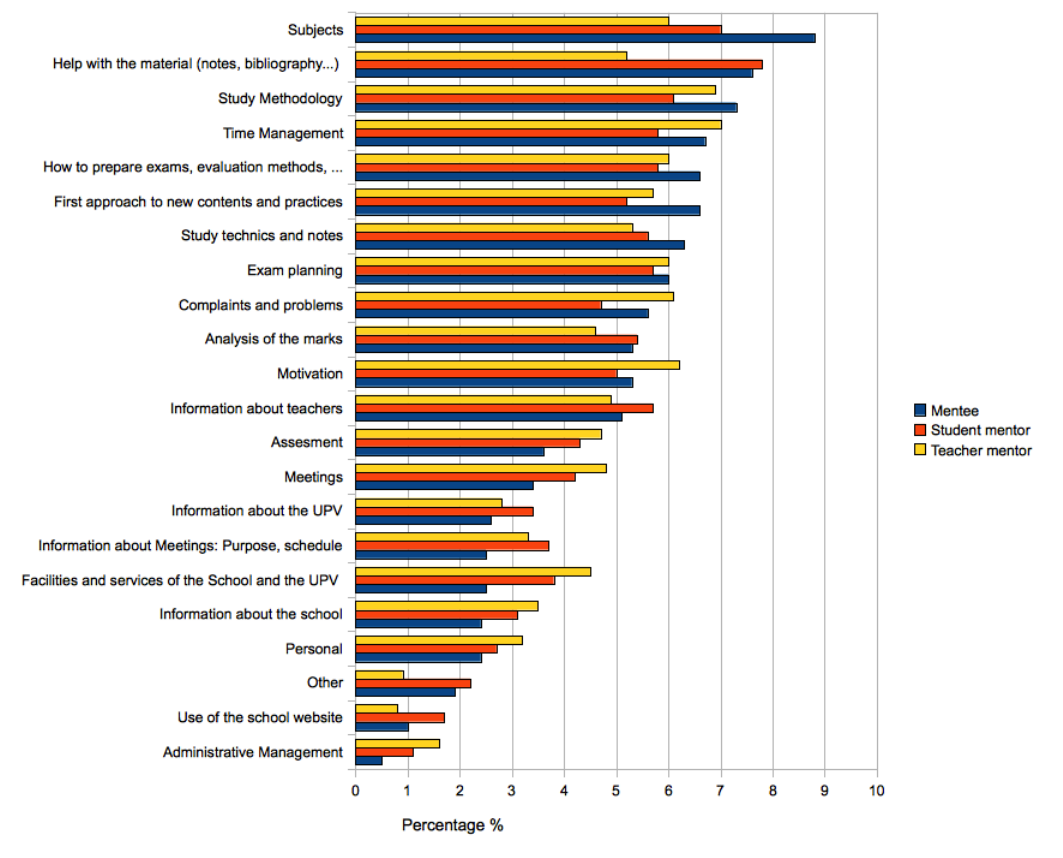
Figure 5. “Most interesting topics treated during the